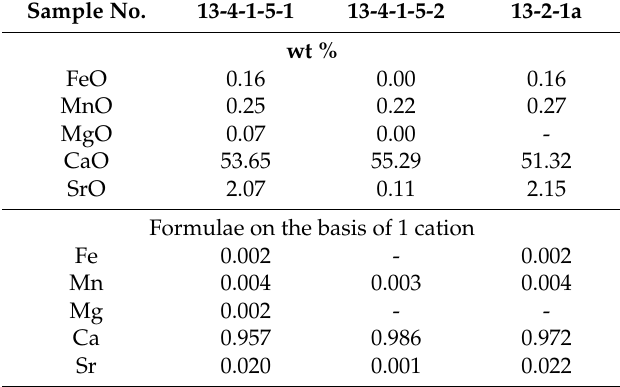
Figure 4. BSE image of typical poikilitic andradite with inclusions of calcite, hastingsite, zeolites, magnetite and pyrite. Zeolites often form intergrowths and aggregates of rectangular shape (bottom). A large number of tiny grains of baddeleyite (bright grains, ≤ 50 µm) occur in the central part of the andradite grain. Mineral abbreviations are from [23]. The image is a mosaic of 160 small 1.2 × 0.8 mm BSE images. Table 1. Representative chemical compositions and mineral formulae of carbonate from the Breivikbotn carbonatite.